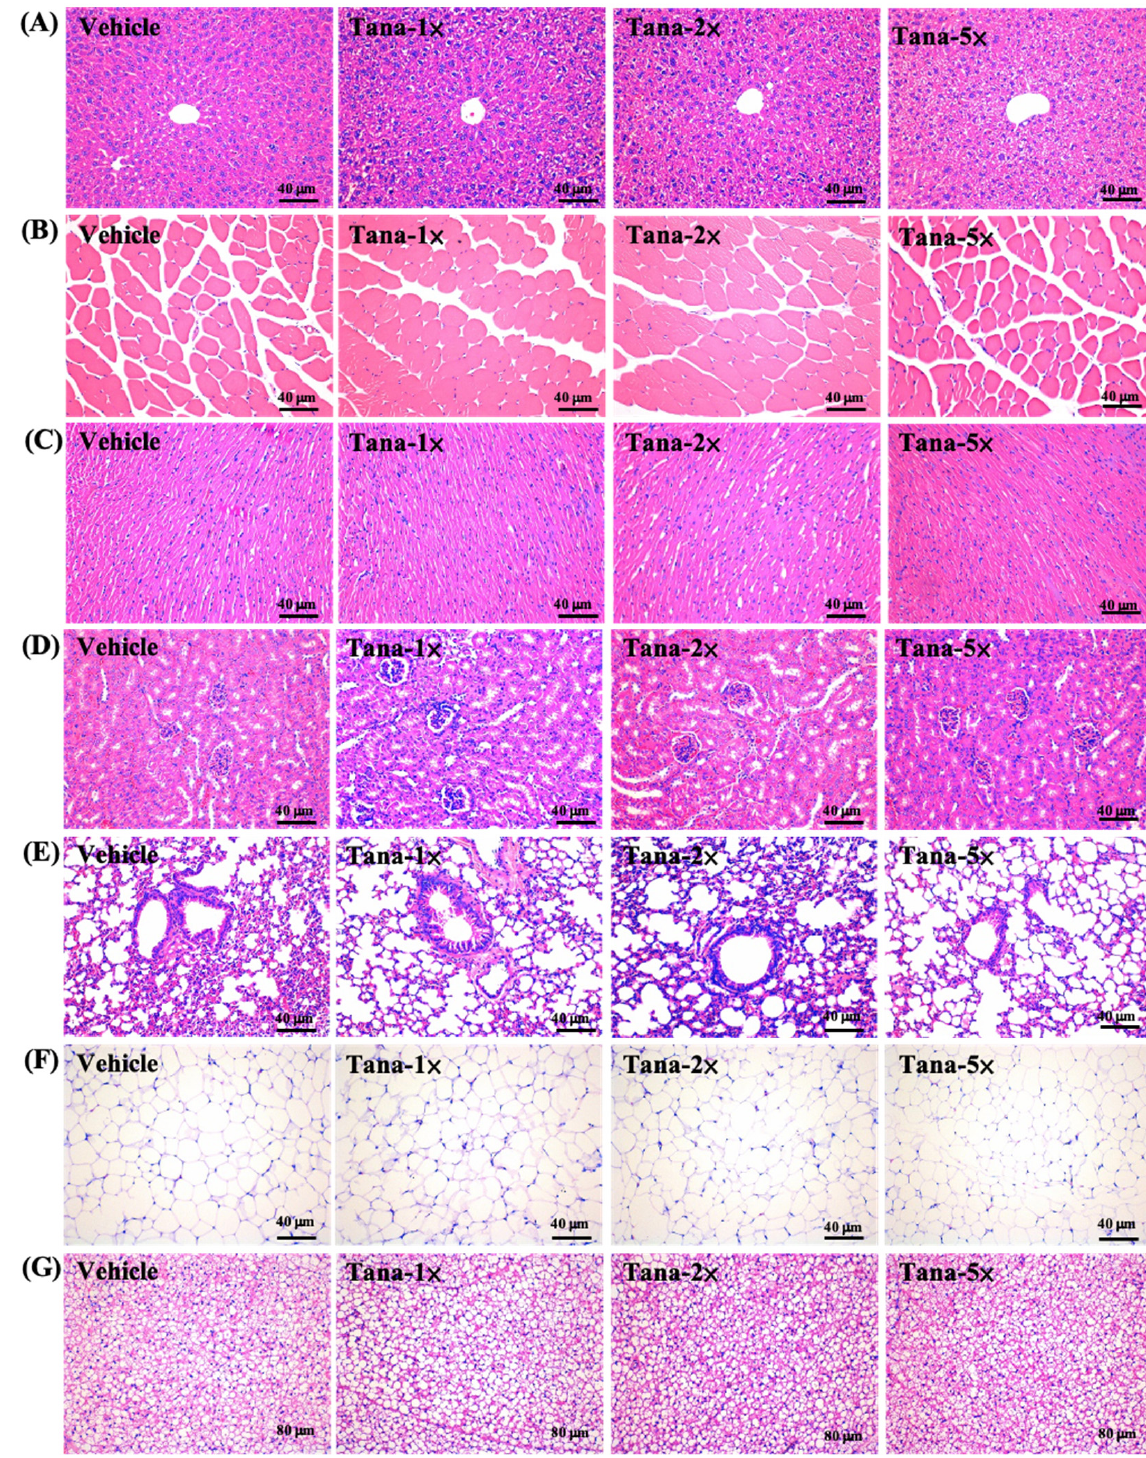
Figure 5. Effect of Tana supplementation on ( A ) liver, ( B ) kidney, ( C ) muscle, ( D ) heart, ( E ) lung, ( F ) adipocyte tissue, and ( G ) BAT tissue in mice. H&E stain, magnification: 200×; bar, 40 μ m; BAT magnification: 100×; bar, 80 μ m.